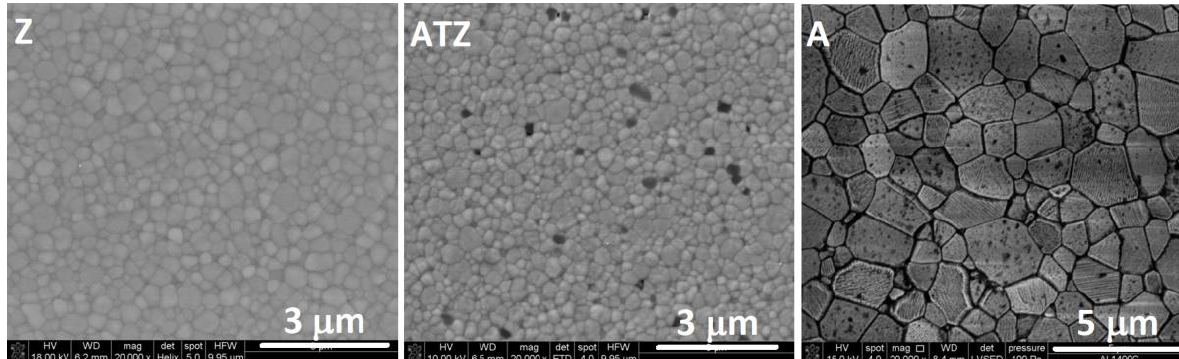
Figure 5. Typical microstructures of the sintered Z, ATZ, and A materials used for the tribological tests.